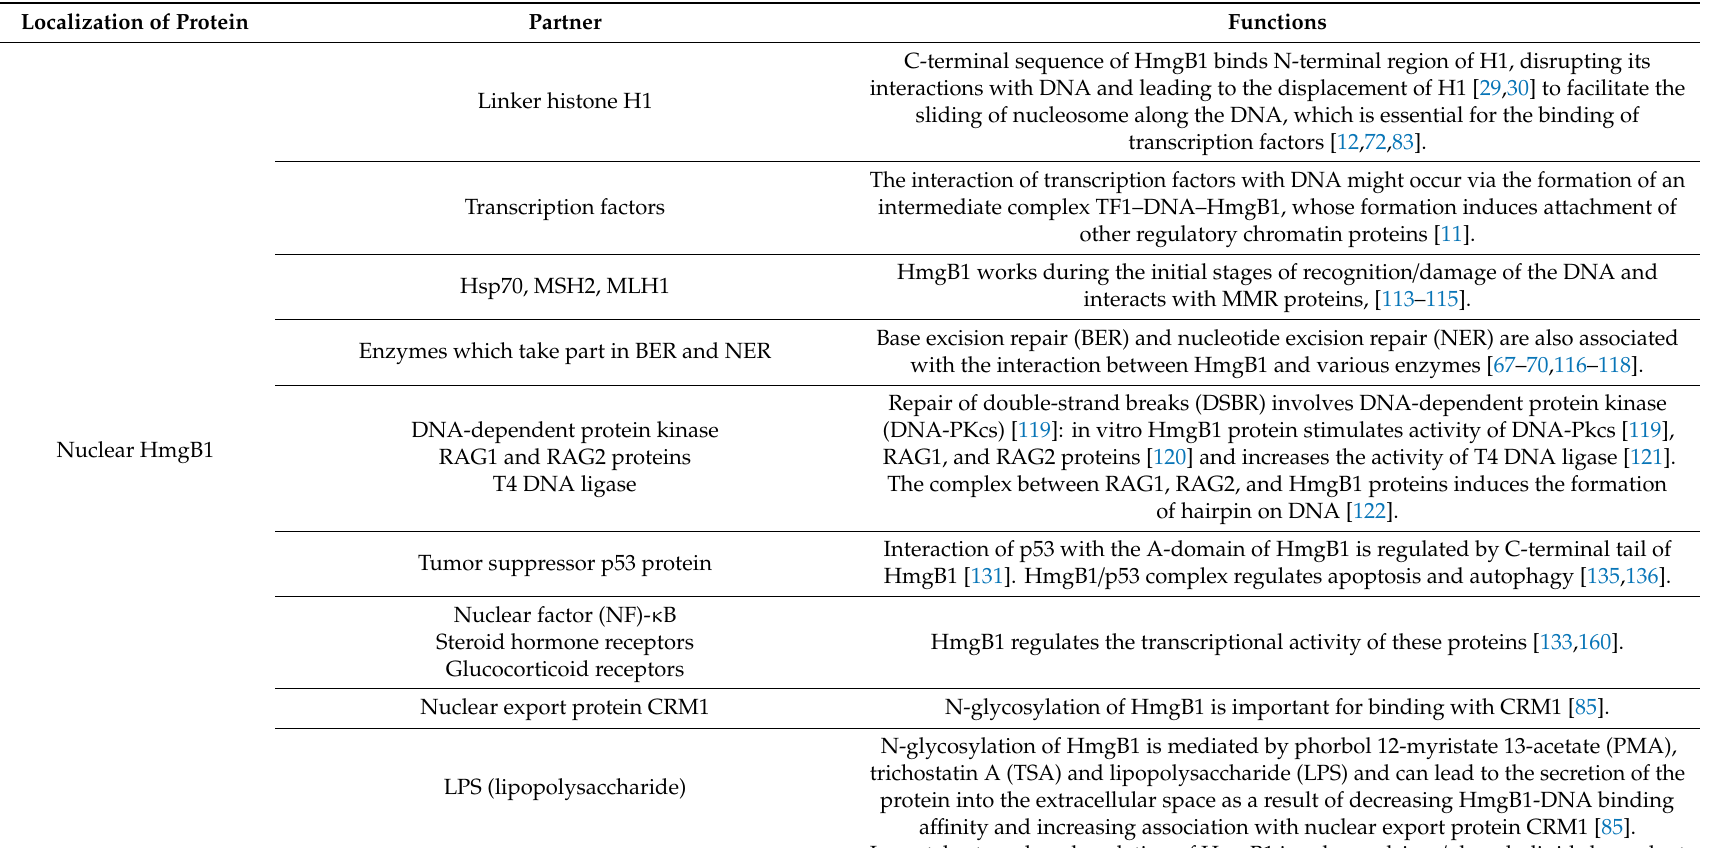
Table 1. Interactions of HmgB1 with other